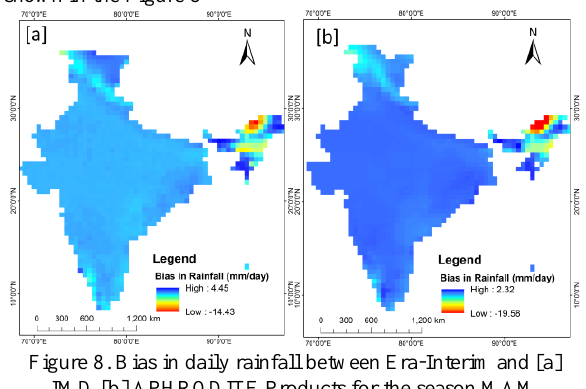
Figure 8. Bias in daily rainfall between Era-Interim and [a]